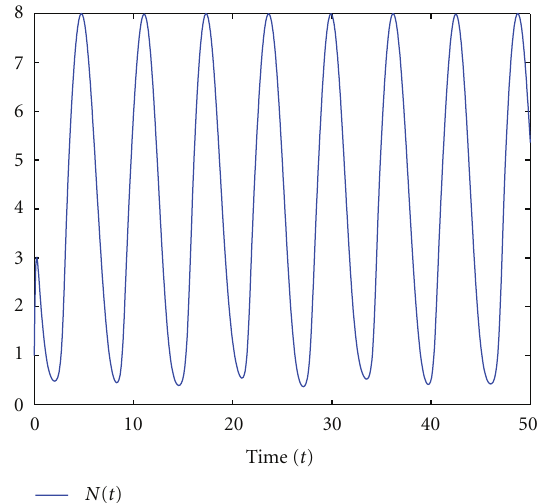
Figure 1: Transient response of state N (cid:6) t (cid:7) when γ (cid:5)